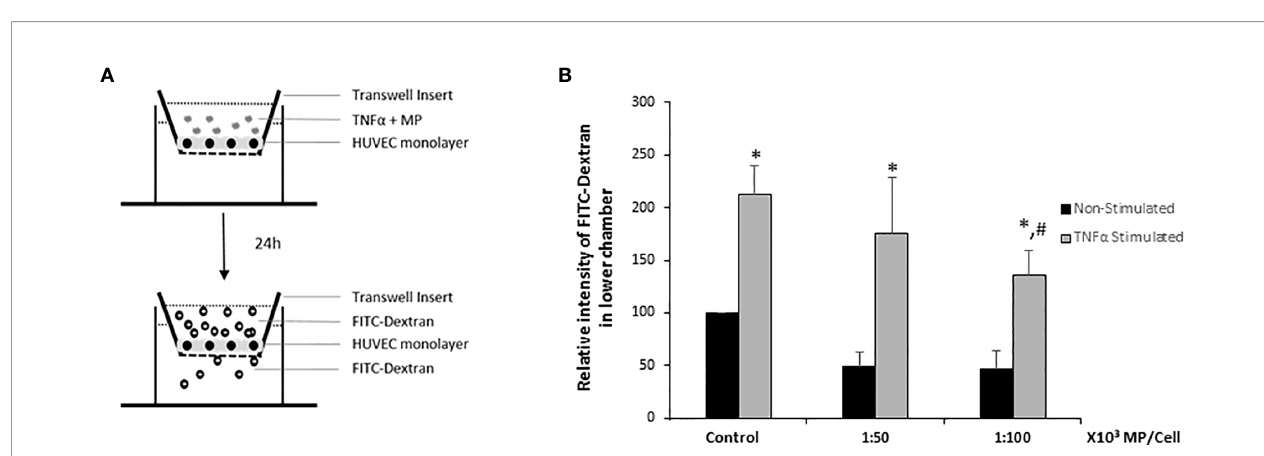
FIGURE 7 | HUVEC barrier integrity. (A) Schematic representation of the endothelial barrier model used in the study. HUVEC were seeded on transwell inserts until con fl uency and then treated with TNF a and MP (1:50,000 and 1:100,000) during 24h. FITC-dextran was added during 2h, after which the fl uorescence intensity in the lower chamber of the transwell system was quanti fi ed. (B) Quantitative results of the HUVEC barrier integrity assay. Data represent means ± SD of 3 experiments using MP from 5 different donors. *p < 0.05 compared with the respective control (Non-Stimulated HUVEC). # p < 0.05 respect to TNF a stimulated HUVEC